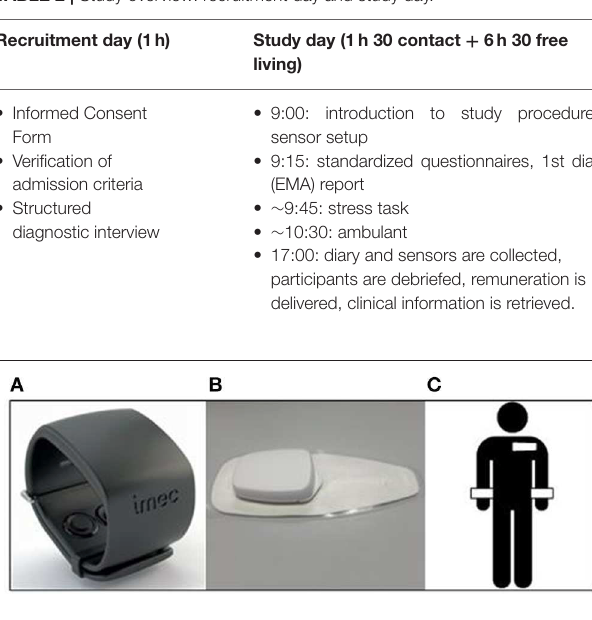
FIGURE 2 | Wearable sensors: (A) Chillband, (B) ECG patch, and (C) sensor